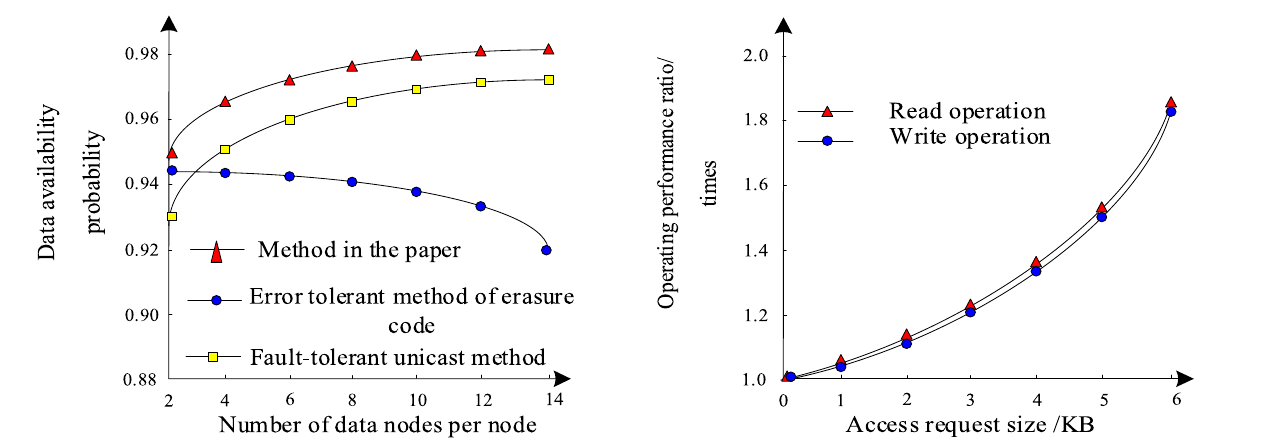
Fig. 5 Data availability comparison Fig. 6 Read/write operation performance